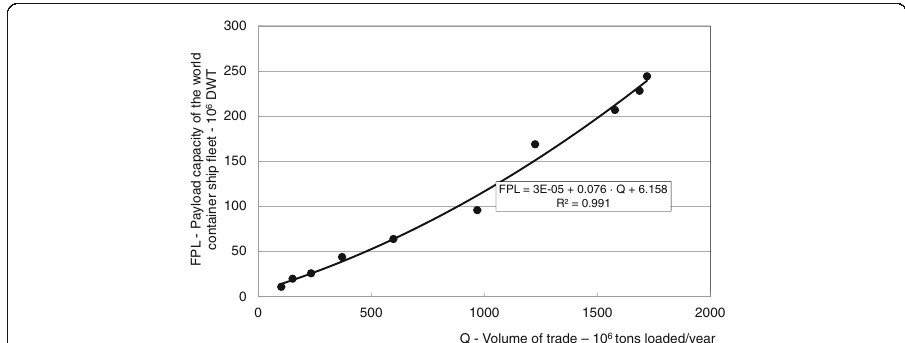
Fig. 1 The containerized freight seaborne trade vs the capacity of container ship fleet (DWT - Dead Weight Tonnage) (Period: 1980 – 2016) (UNCTAD